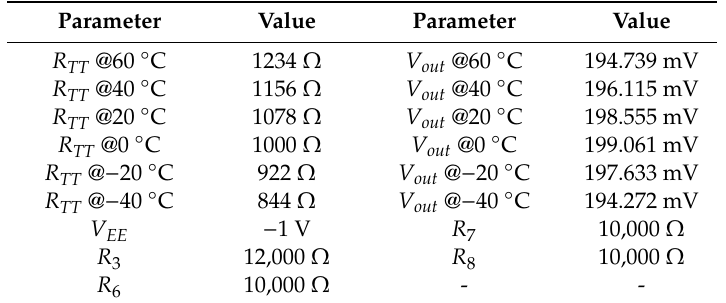
Table 5. MEMS gyroscope temperature bias compensation circuit parameters.